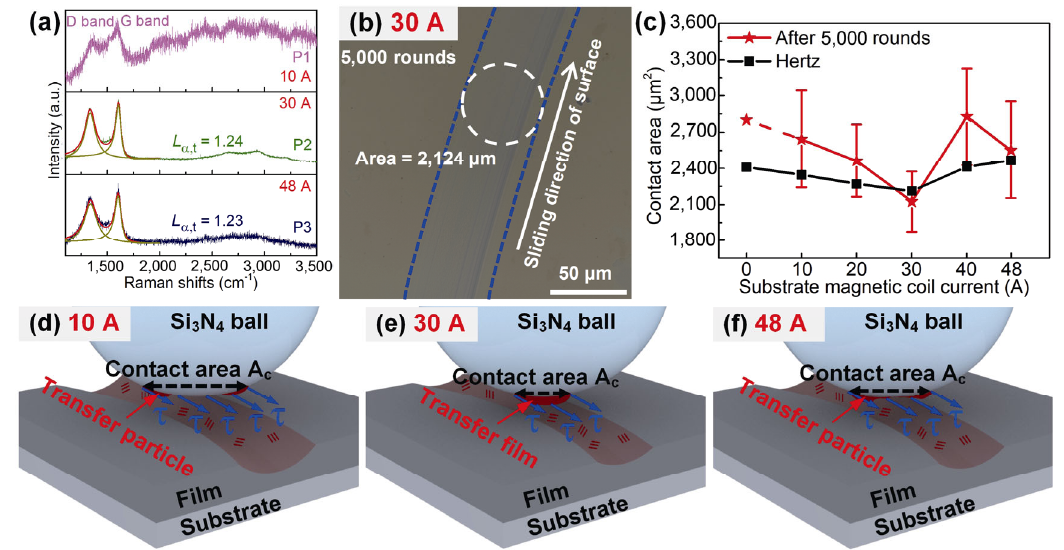
Fig. 7 (a) Raman spectra of the marked positions on the optical images of the transfer films; (b) method for measuring the real contact area in a wear track; (c) trends of Hertz and real contact areas with I s ; and (d–f) schematics of the low friction mechanisms associated with the contact area and transfer layer at the